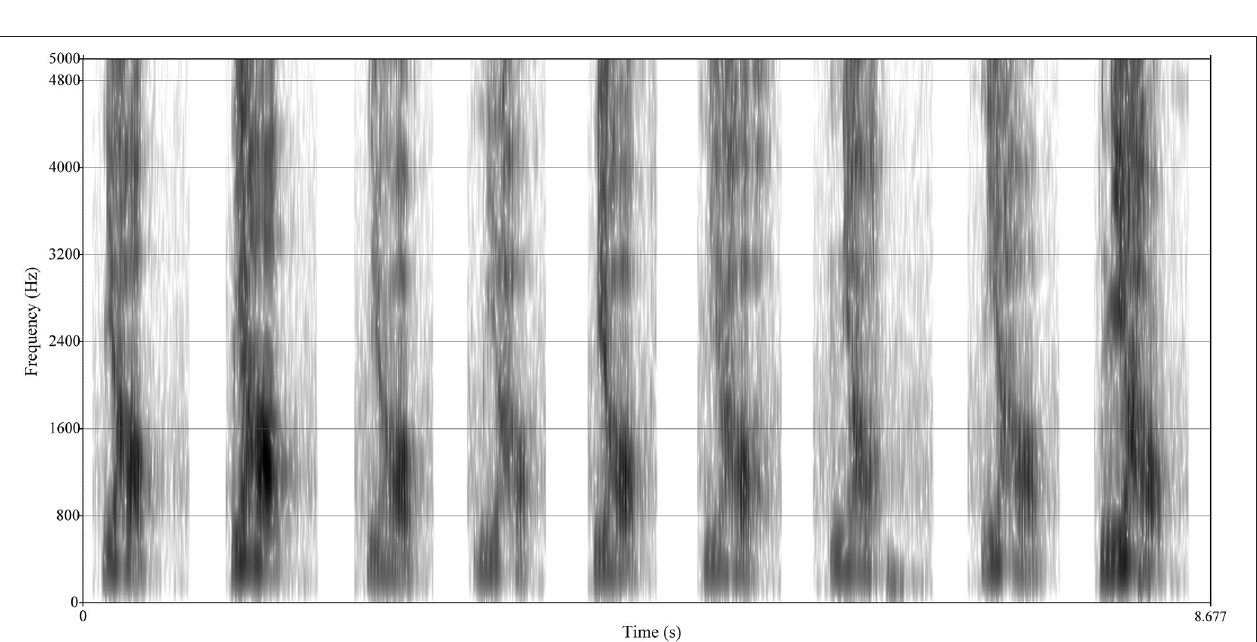
FIGURE 4 | Oscillograph comparison of different emotional voices of respondents. The Y -axis of the oscillograph expresses time (unit: s). The X -axis, amplitude, has different units of expressions, either decibel (dB) or relative values; it ranges between [ − 1, 1] and can be expressed by a percentage or frequency value ( Sueur, 2018; Wayland, 2018 ). From the left to the right, a respondent records nine emotions of “ ” from ID.1 to ID.9.